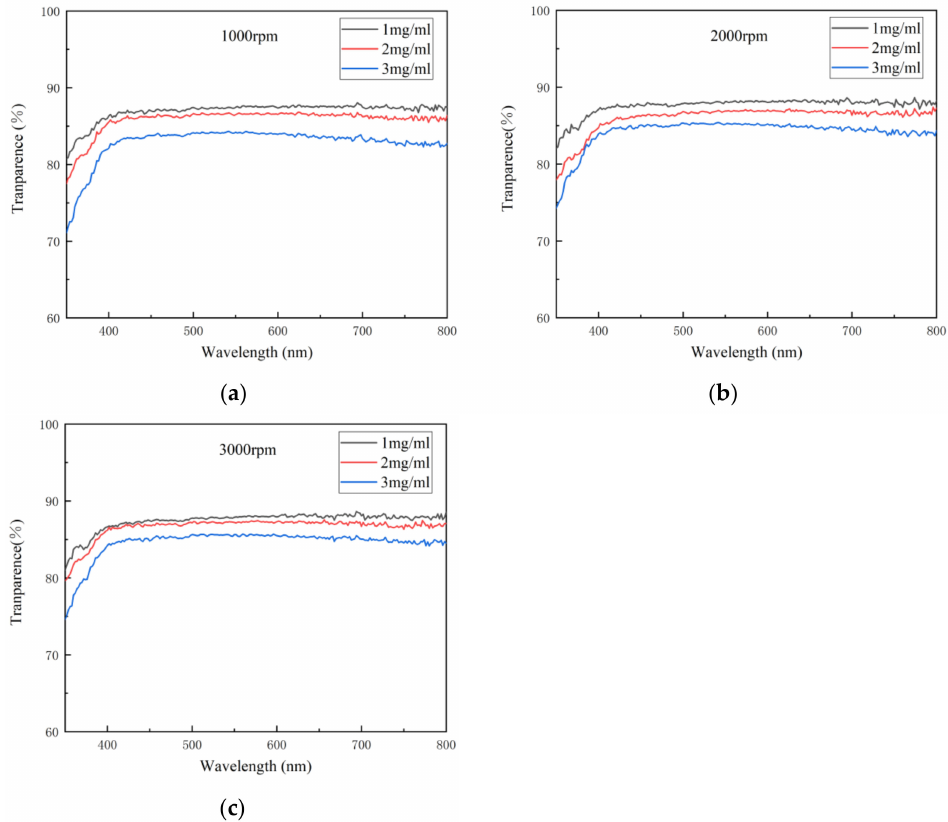
Figure 4. The variation in transmittance spectra with concentration at different spin speeds: ( a ) 1000; ( b ) 2000; ( c ) 3000